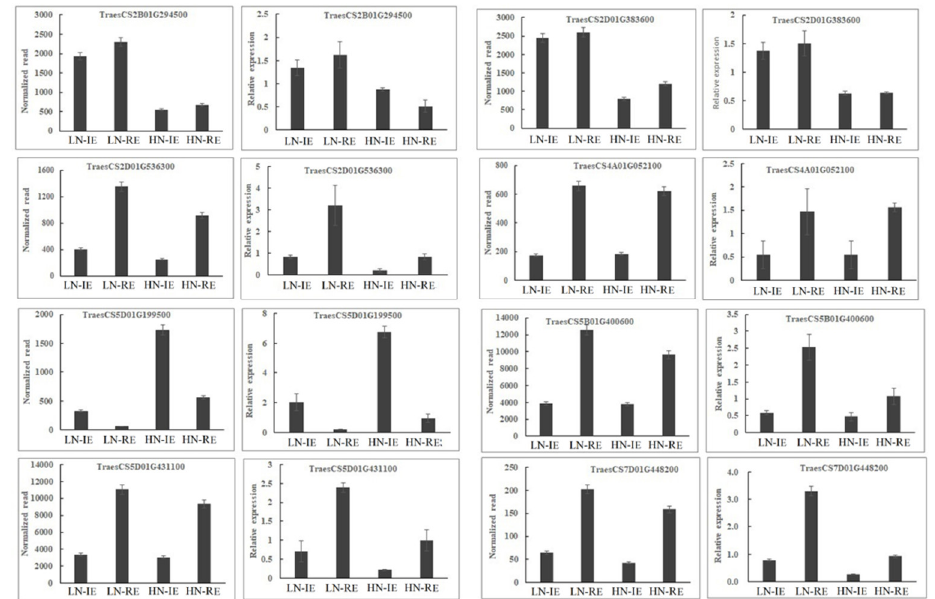
Figure 3. Verification of expression levels for eight differentially genes in the inner and outer endosperm grown under high or low nitrogen conditions. HN-IE and HN-RE are samples from innermost endosperm region and the remaining endosperm region under high nitrogen treatment, respectively. LN-IE and LN-RE are samples from innermost endosperm region and the remaining endosperm region under low nitrogen treatment, respectively.